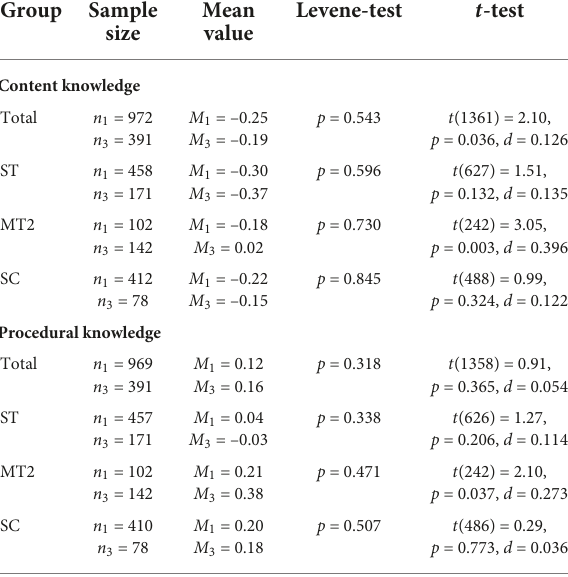
TABLE 1 Reliabilities, infit, and discrimination estimated in the rating scale model.